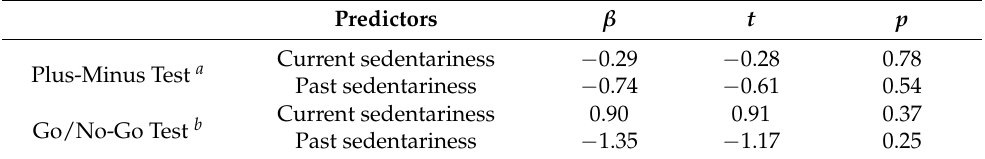
Table 2. Multiple linear regression coefficients on z-scores of the “Go/No-Go” (cognitive inhibition) and “Plus-Minus” (cognitive flexibility) tests for the current and past sedentariness ratio. Predictors β t p Current sedentariness − 0.29 − 0.28 0.78 Plus-Minus Test a Past sedentariness − 0.74 − 0.61 0.54 Current sedentariness 0.90 0.91 0.37 Go/No-Go Test b Past sedentariness − 1.35 −